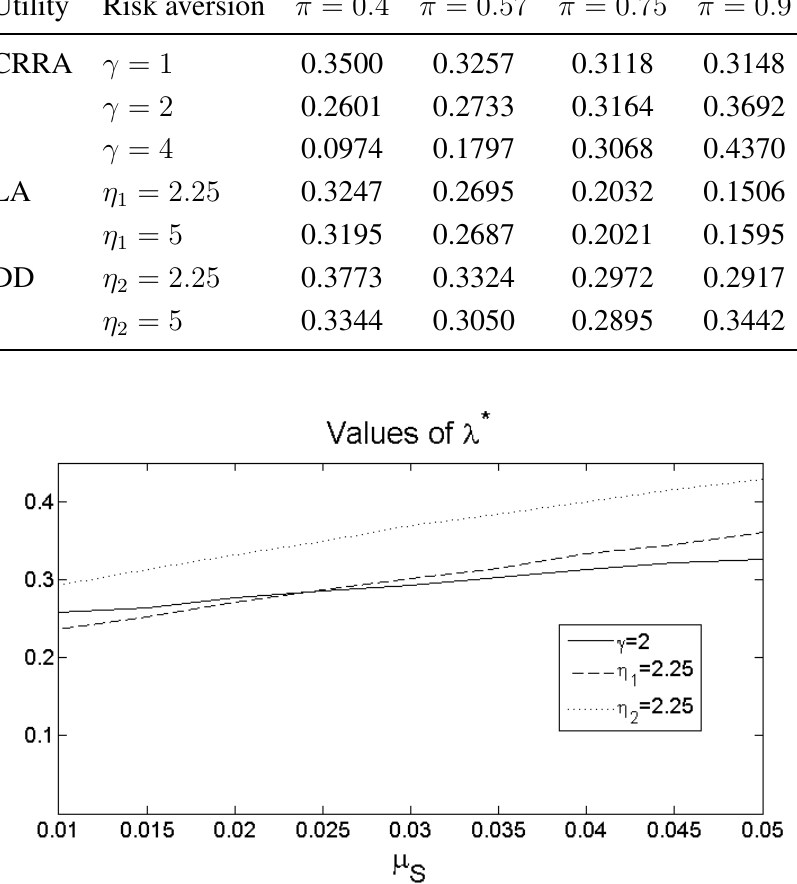
Figure 2. Values for the indifference switching λ ∗ for different levels of the salary drift µ